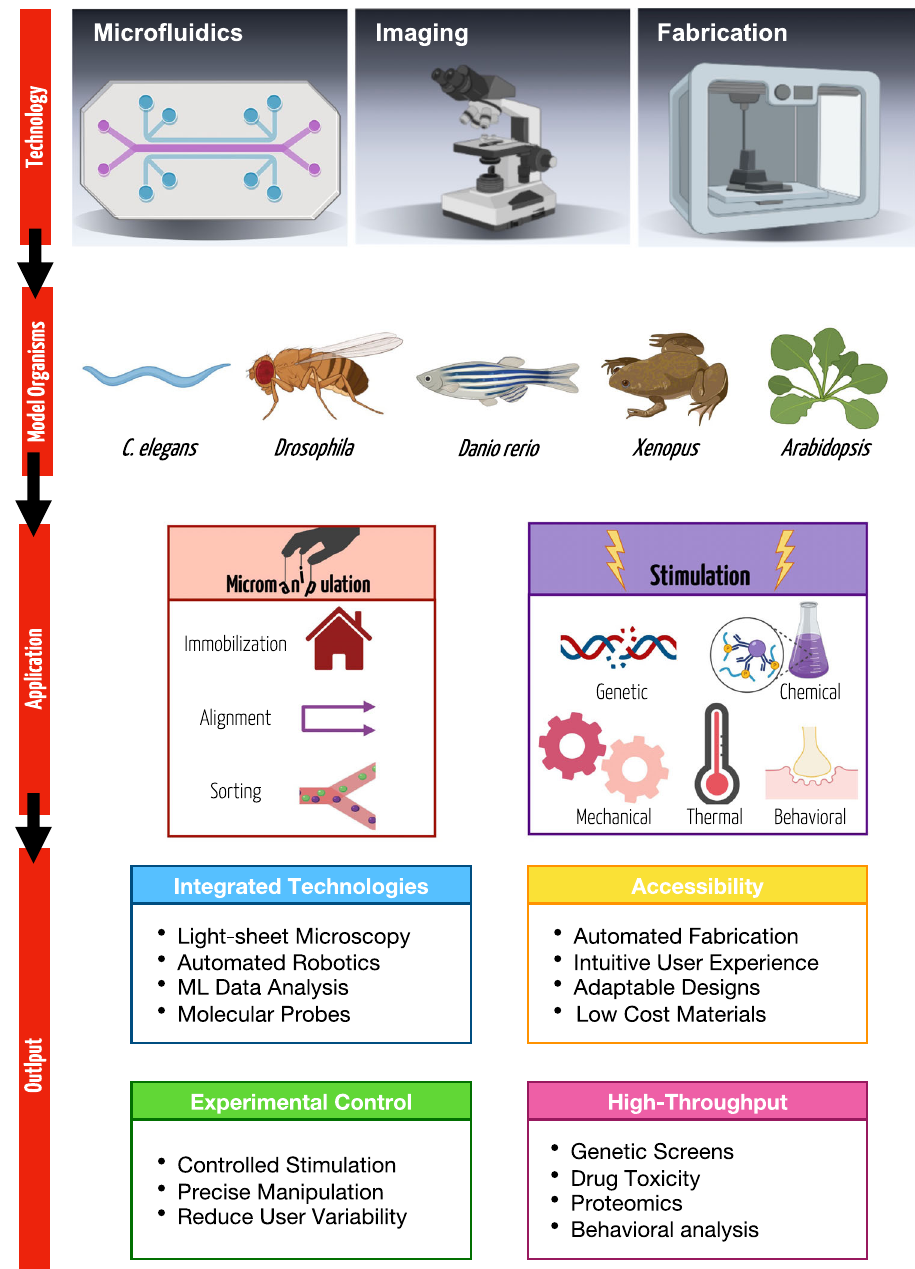
Fig. 1 Future transdisciplinary directions for biological model organism research enabled by novel micro fl uidic approaches. Novel microfabrication techniques combined with creativity enable the production of different micro fl uidic tools that, in turn, facilitate the development of novel experimental paradigms to be used with small multicellular model organisms. Micro fl uidics empower researchers with tremendous control over sample stimulation while also enabling precise manipulation of samples, and being compatible with high-resolution live imaging. The potential of these microtechnologies is accelerating as they are integrated with additional technologies, become more accessible, and are designed to be multifunctional. Figure created with